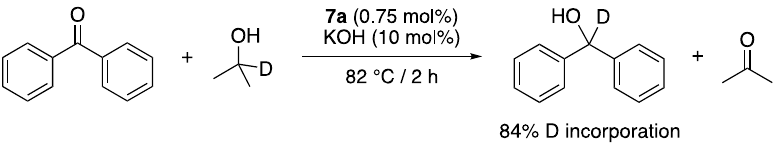
Figure 1. ( η 6 - p -cymene)Ru(II) complexes 7a – e bearing picolyl-NHC ligands.